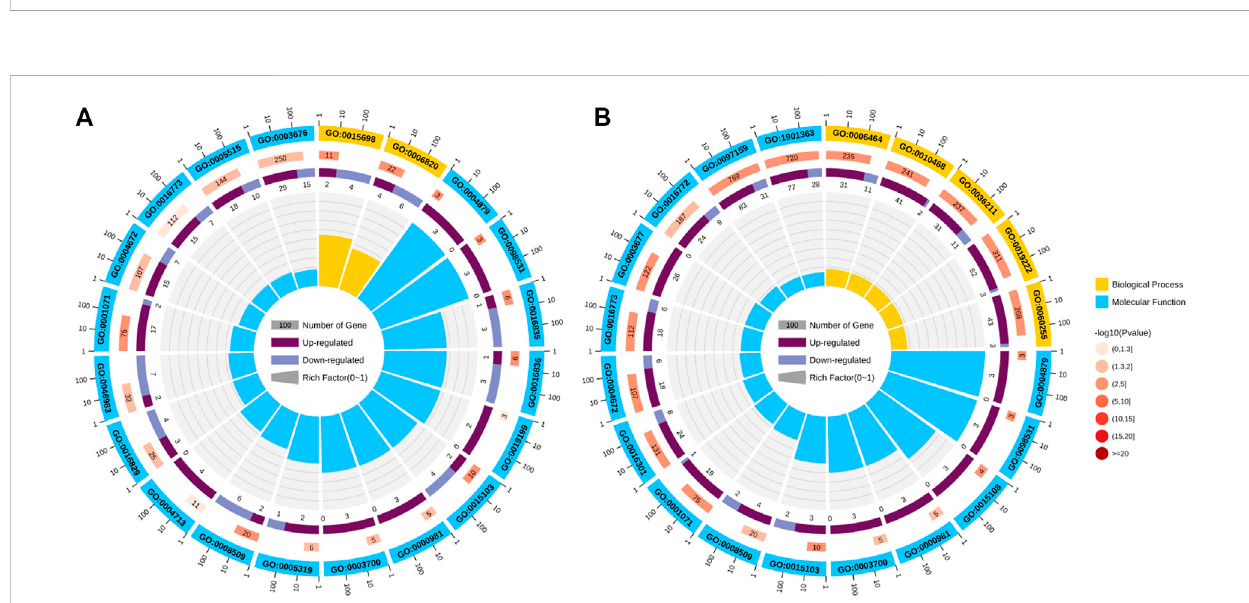
FIGURE 5 Signi fi cant GO terms enriched by differentially expression genes (DEGs). (A) Control vs. T24. (B) Control vs. T48. The Signi fi cant GO term analysis of the DEGs falls into the following GO categories: biological process and molecular